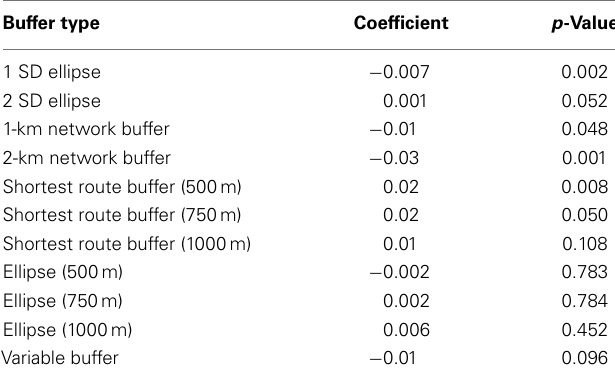
Table 4 | Results for the regression analysis between the percentage of GPS points inside the 11 buffer types and distance from home to center